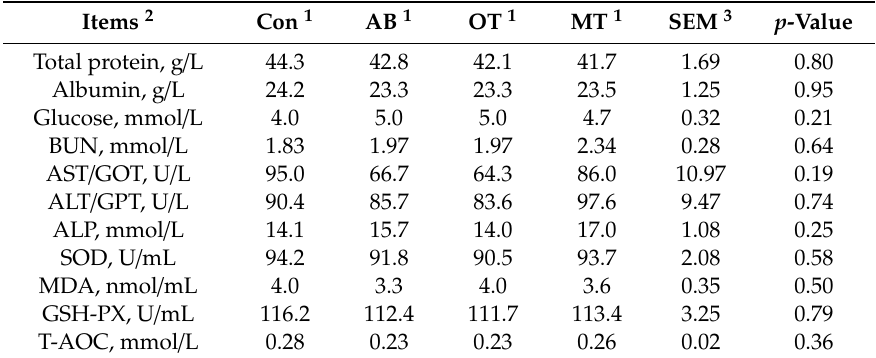
Table 3. E ff ect of dietary supplementation with tributyrin in combination with di ff erent essential oils on serum characteristics of weaned